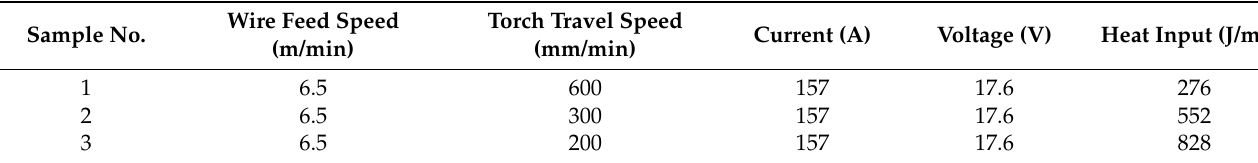
Table 2. Process parameters of WAAM deposition.